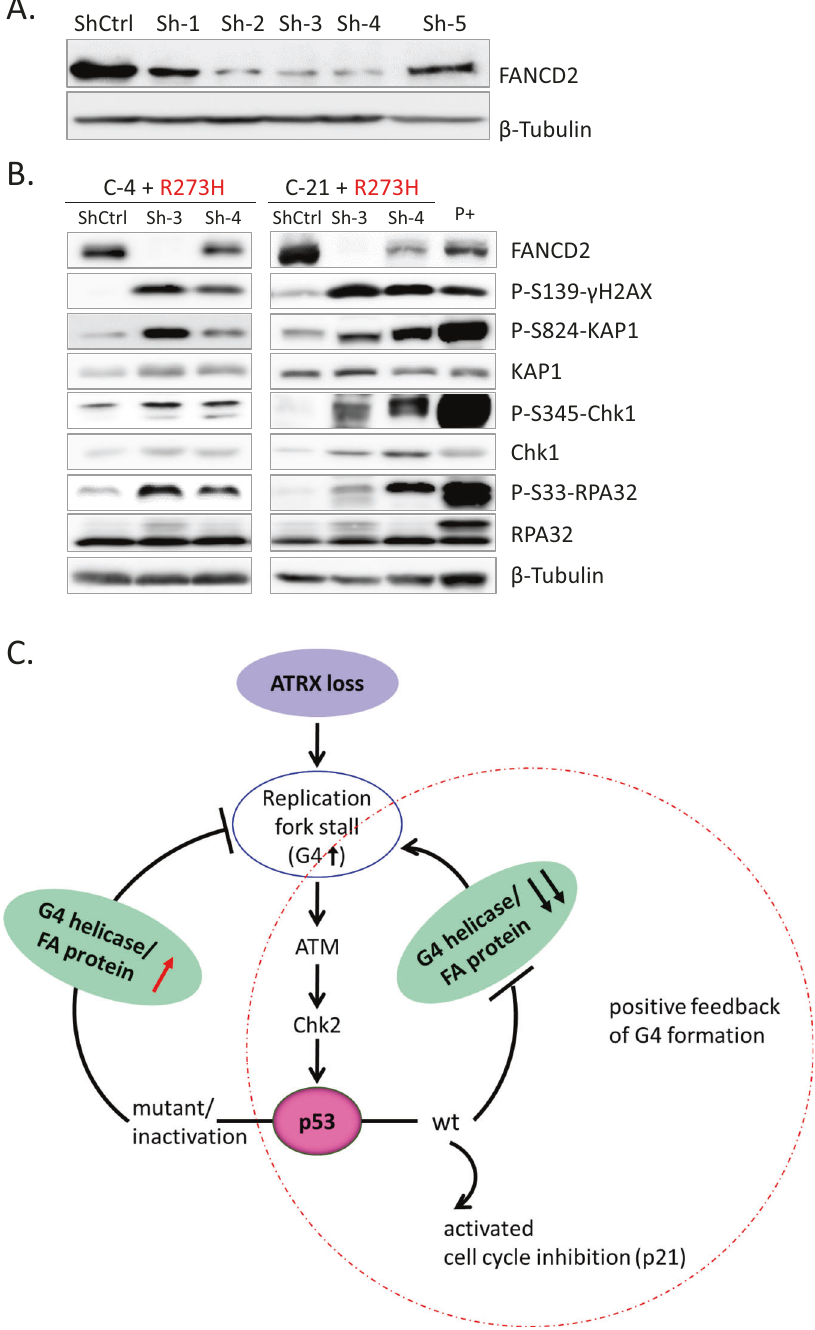
Fig. 6 p53 de fi ciency limits ATRX loss-induced RS and genome instability through the FA pathway protein, FANCD2. A A western blot analysis showing the silencing ef fi ciency of shRNAs against FANCD2 in HeLa cells. B FANCD2 protein depletion by shRNA was con fi rmed by immunoblotting. FANCD2 knockdown in p53-inactivated ATRX KO NGP cells resulted in the further activation of the DDR and RS. NGP cells treated with doxorubicin (0.5 μ g/mL, 24 h) were used as a positive control. C Model for linking ATRX, p53, and replication fork-protecting molecules (G4 helicases or the FA pathway protein, FANCD2) to the DDR, RS, and genomic instability. G4 helicases or FANCD2 activation protected cells from RS in p53-inactivated ATRX-de fi cient cells. In TP53 wt cells, the loss of ATRX resulted in DNA damage and RS in response to replication fork stalling. p53 inactivation inhibited replication fork stalling by triggering G4-resolving helicases and FANCD2 expression, which may promote G4 structure resolution and replication fork Emerging studies revealed that cancer cells with ALT were mostly depend on ATM-associated DDR signaling pathways for hypersensitive to the inhibition of ATR, another component of DNA repair [15, 44], which is consistent with other fi ndings [45]. DNA damage checkpoint-activating kinases other than ATM in p53 inactivation or mutant TP53 with ATRX de fi ciency inhibited human cells [46]. In contrast, in several telomerase-positive and the ATM/CHK2/p53 pathway, which may be attributed to the ALT-positive NB or non-NB cell lines treated with an ATR inhibitor, inhibited formation of G4.